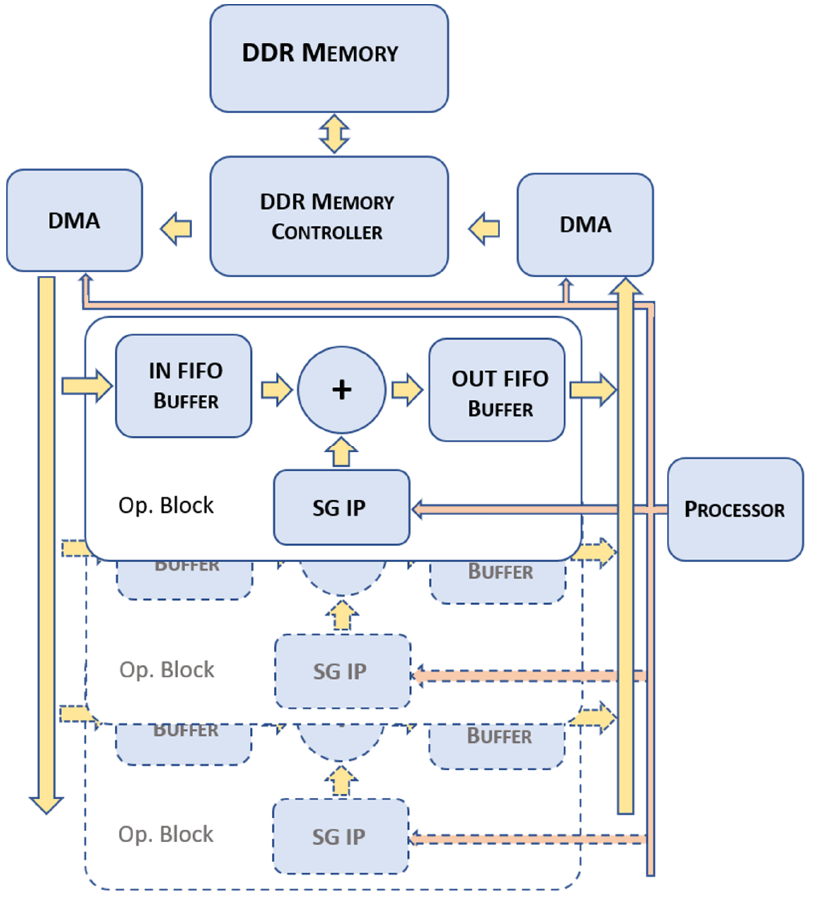
Figure 3. Example of architecture with a processor connected to multiple SG IPs working in parallel.